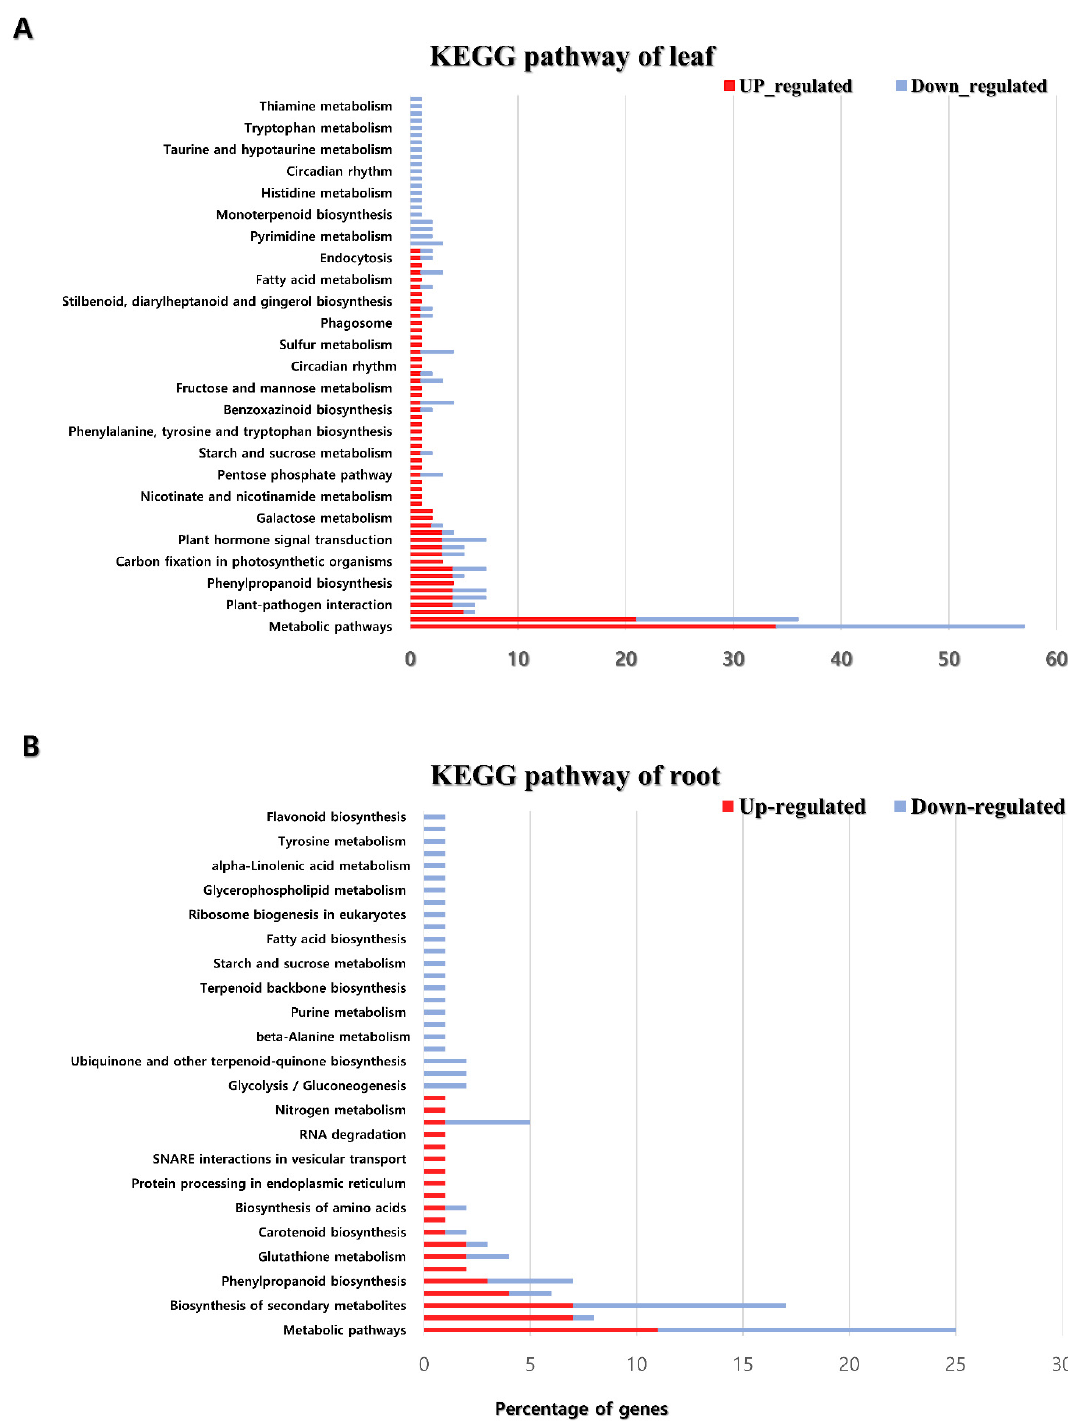
Figure 4. KEGG pathway analysis of leaf ( A ) and root ( B ) DEG.